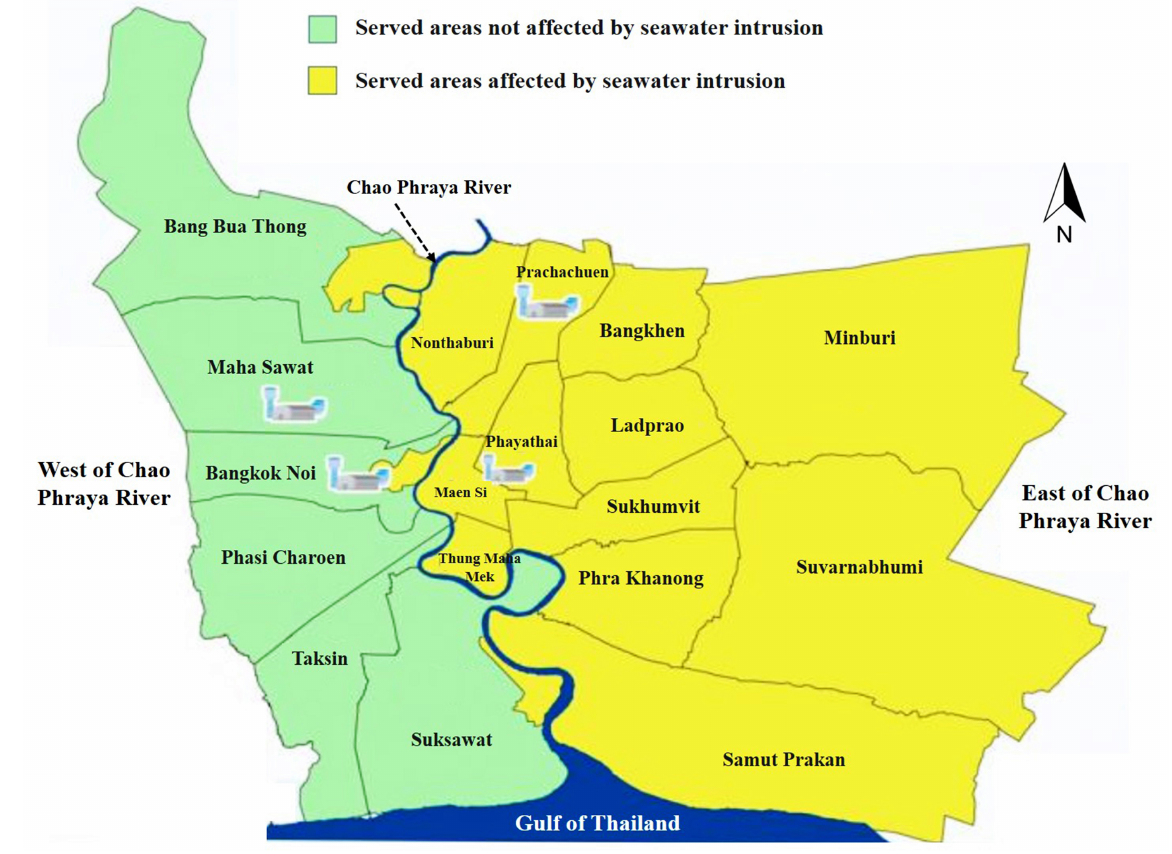
Fig. 1. MWA service areas getting effects of seawater intrusion. (Source: